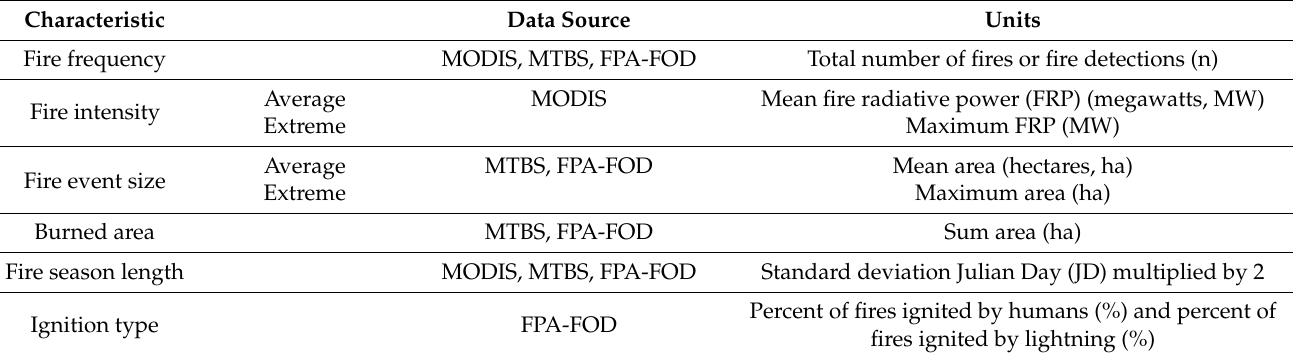
Table 1. Fire characteristics derived for the contiguous U.S. at a 50 km spatial resolution and an annual temporal resolution (values are per pixel per year) from satellite data and government records to delineate modern pyromes based on fire physical characteristics. All data were derived from the Moderate Resolution Imaging Spectroradiometer (MODIS) Active Fire Product for 2003–2020, from the Monitoring Trends in Burn Severity (MTBS) Burned Areas Boundaries Dataset for 1984–2015, and from the Fire Program Analysis fire-occurrence database (FPA-FOD) for